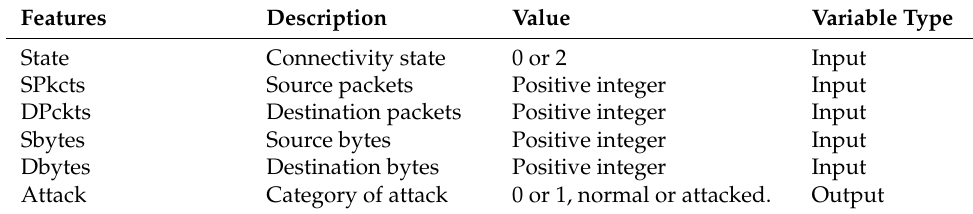
Table 3. IOR Dataset Description.